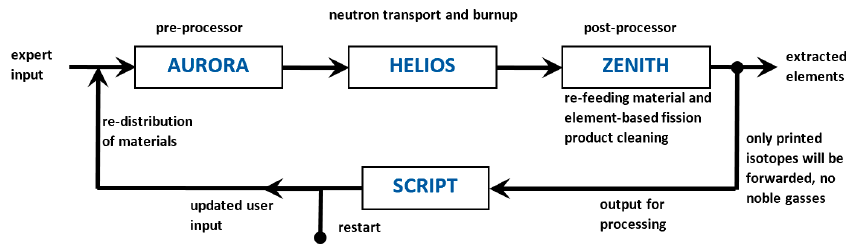
Figure 2. Description of the calculation cycle for the simulation of an MSR, based on the HELIOS package.